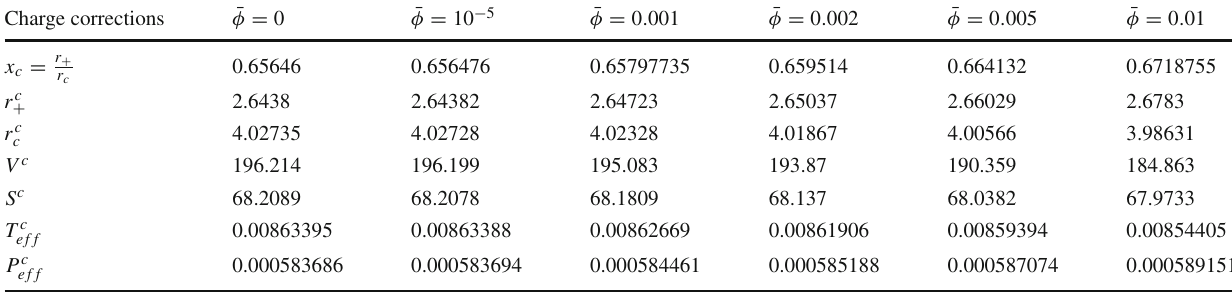
Table 1 Critical point with different charge correction ¯ φ for k = 1 , q = 1 Charge